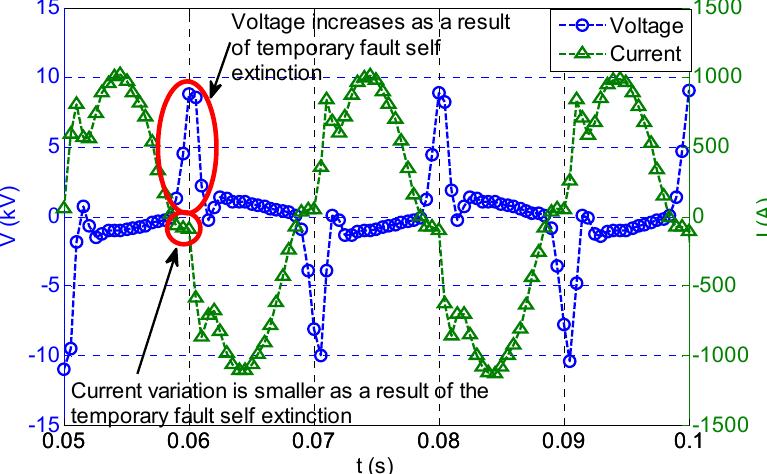
Figure 8. Observed cumulative probability for the arc voltage.